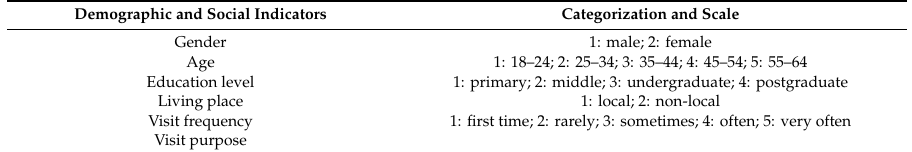
Table 2. Demographic and social indicators in the questionnaire, with their categorizations and scales. Demographic and Social